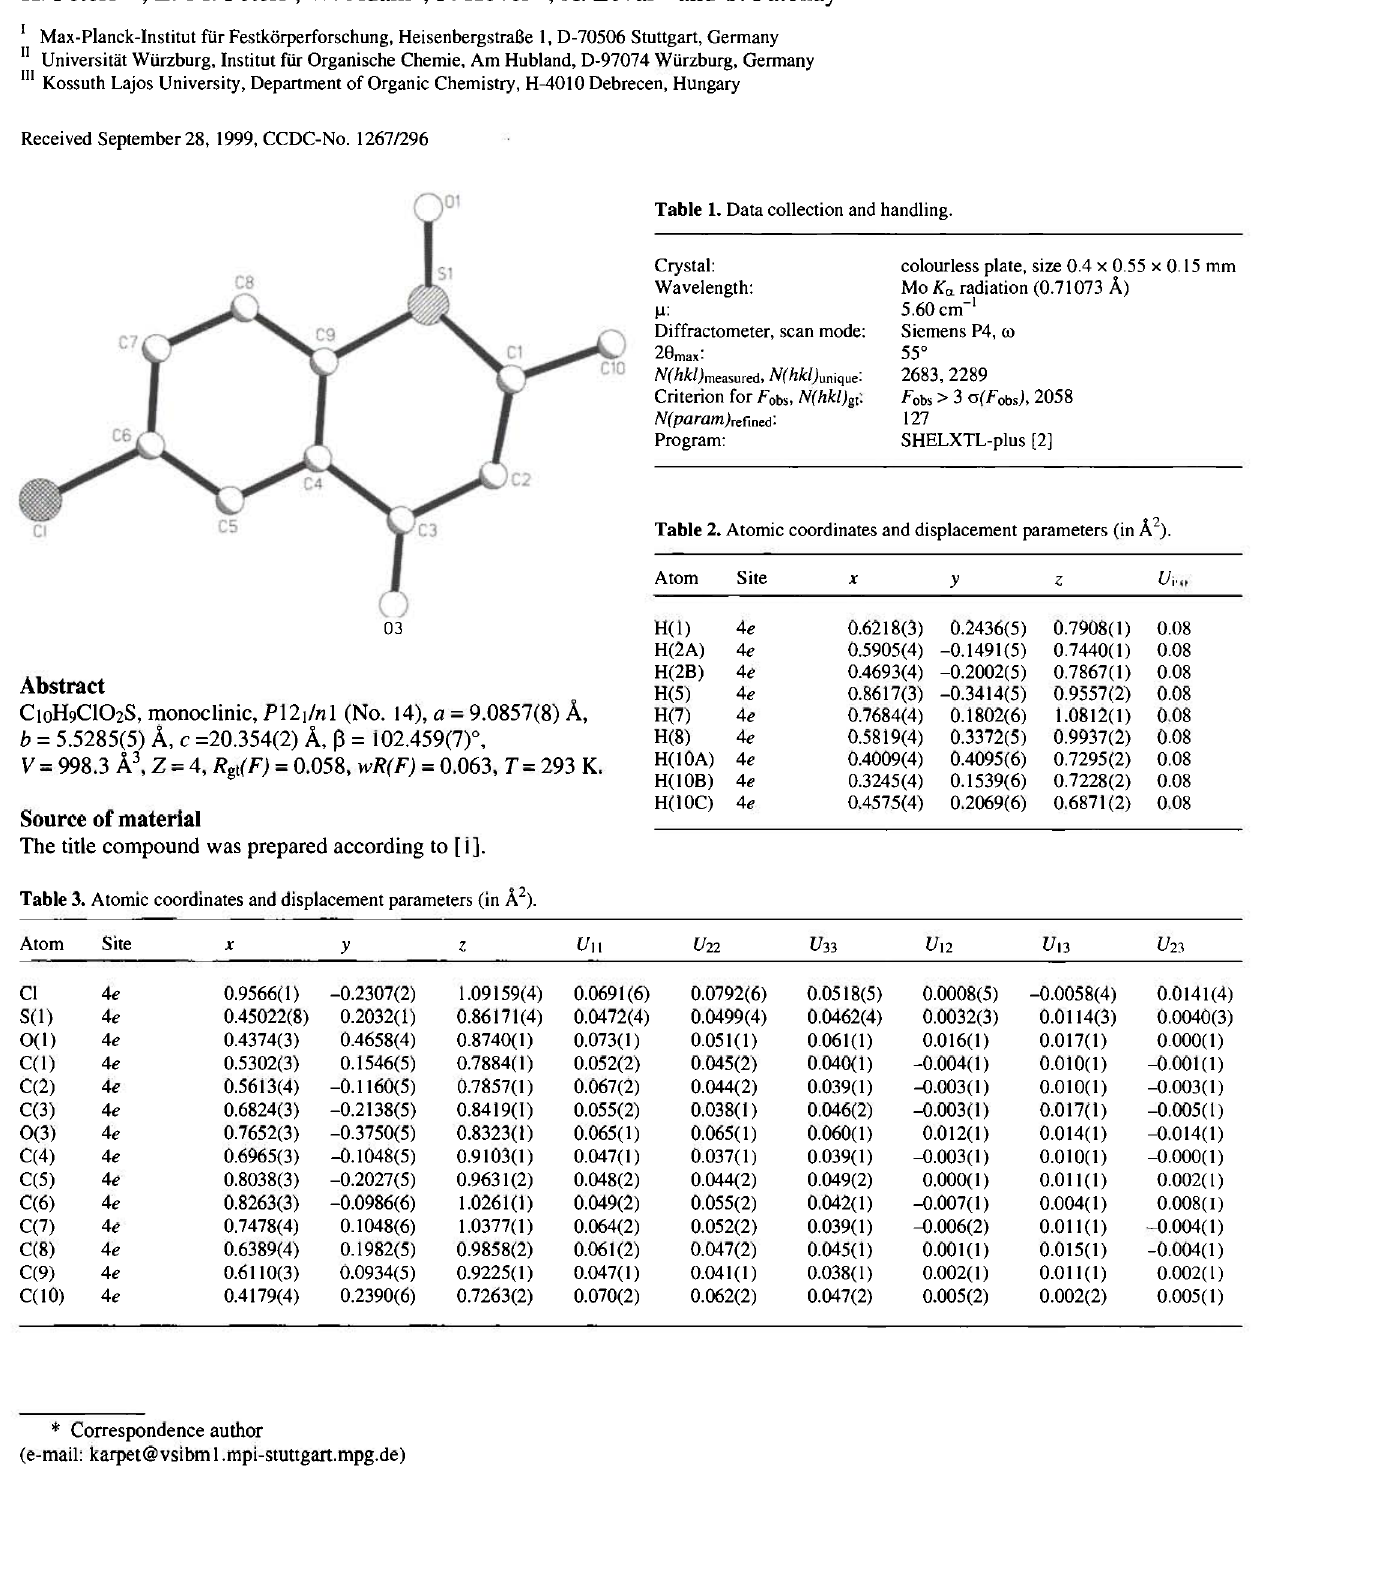
Table 1. Data collection and handling. Crystal: